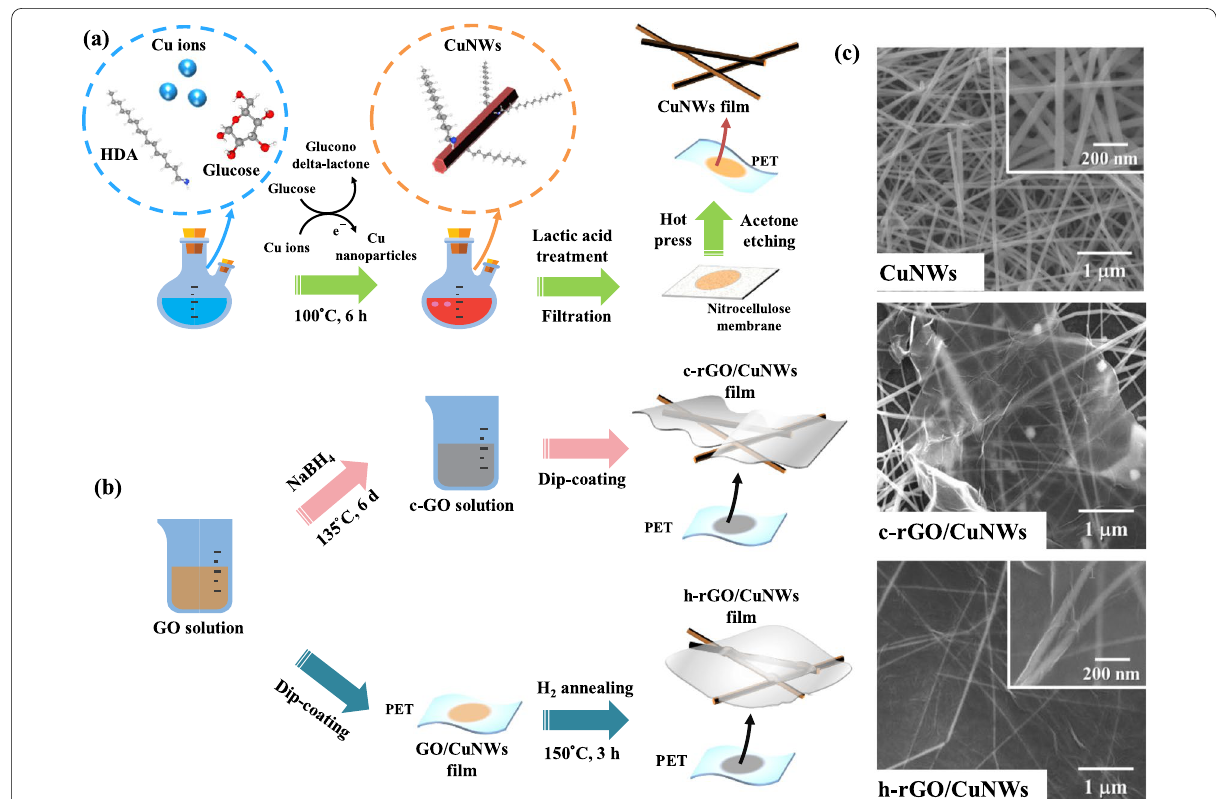
Fig. 1 a Schematic illustration of the preparation of CuNWs film, which used glucose as a reducing agent and HDA as a capping agent and adopted lactic acid to remove residual copper oxide and other organic chemicals. b Schematic illustration of the preparation of c‑rGO/CuNWs and h‑rGO/CuNWs films. c FESEM images of CuNWs, c‑rGO/CuNWs, and h‑rGO/NWs. The CuNWs exhibit an average diameter of 57.78 and a length of > 10 μm. The CuNWs network cannot be completely covered by c‑rGO layers, leading to invalid protection. In contrast, h‑rGO can uniformly cover the CuNWs and increase the contact area between